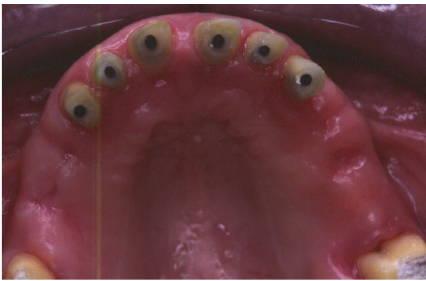
Figure7:Theabutmentpreparationsweredoneinoneappointment with a feather-edge finishing line.